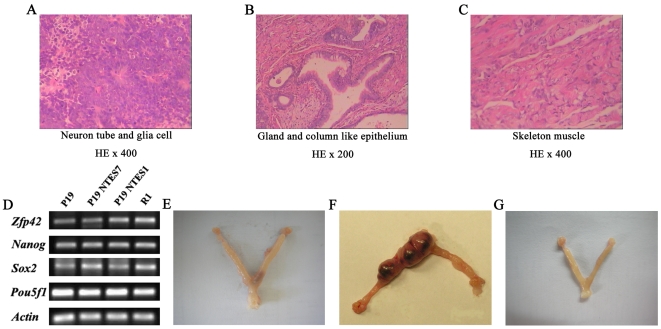
Pluripotency verifications of P19 NTES cells.Teratoma formation, RT-PCR and tetraploid aggregated assays were used to evaluate the pluripotency of P19 NTES cells from different aspects. (A), (B), (C) HE staining results of the paraffin embedded sections of teratoma derived from P19 NTES7. As shown in A-C, neuron tube and glia cells, gland, and column-like epithelium and skeleton muscle, which represent the three germ layers, respectively, could be observed in teratoma tissues. (D) The expression of pluripotent genes of P19 and P19 NTES cells as determined by RT-PCR. (E) The uterus and the dead tetraploid embryos of P19 cells at E8.5. (F) The uterus and the dead tetraploid embryos of P19 NTES7 at E8.5. (G) The uterus transplanted with tetraploid embryos derived from P19 NTES1 at E8.5.